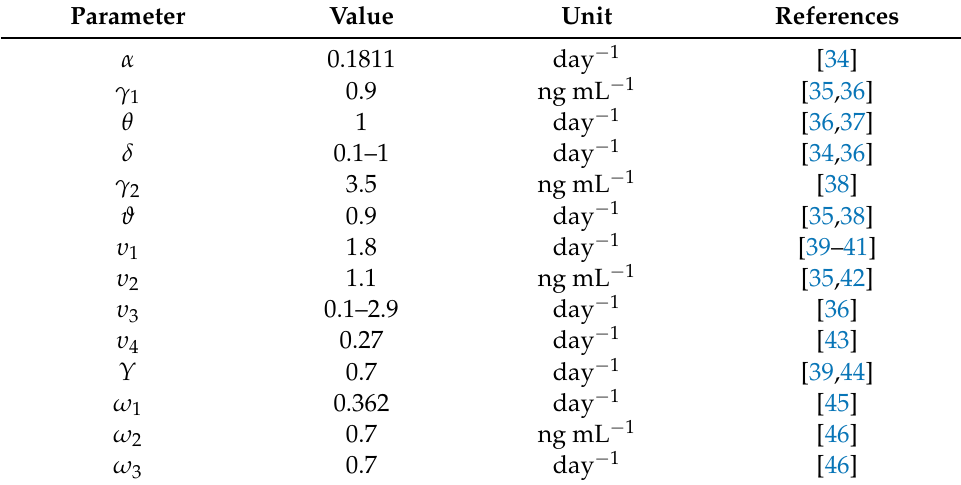
Table 2. Model Parameter